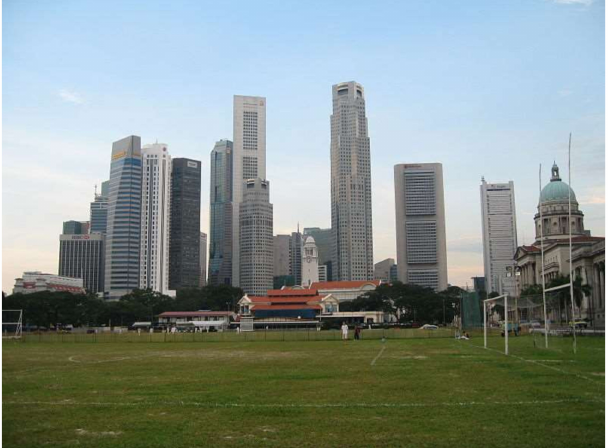
Figure 5. The Padang (Terence Ong, https: // commons.wikimedia.org / wiki / File:Middle_Road,_Singapore